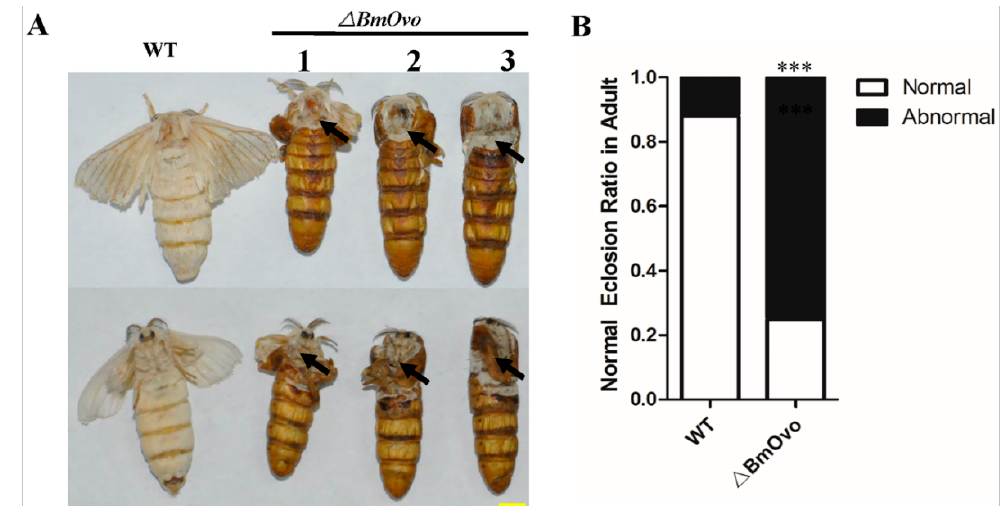
Figure 3. The BmOvo mutants do not undergo metamorphosis from the pupal to adult stage. ( A ) Images of wild-type and BmOvo mutant animals after the pupal to adult transition. Scale bar, 2 mm. ( B ) The fraction of wild-type (n = 200) and BmOvo mutant animals (n = 167) that eclosed normally. The asterisks indicate significant differences (** p < 0.01 and *** p < 0.001) compared with the wild type in the pupae stage determined using a two-tailed t -test.